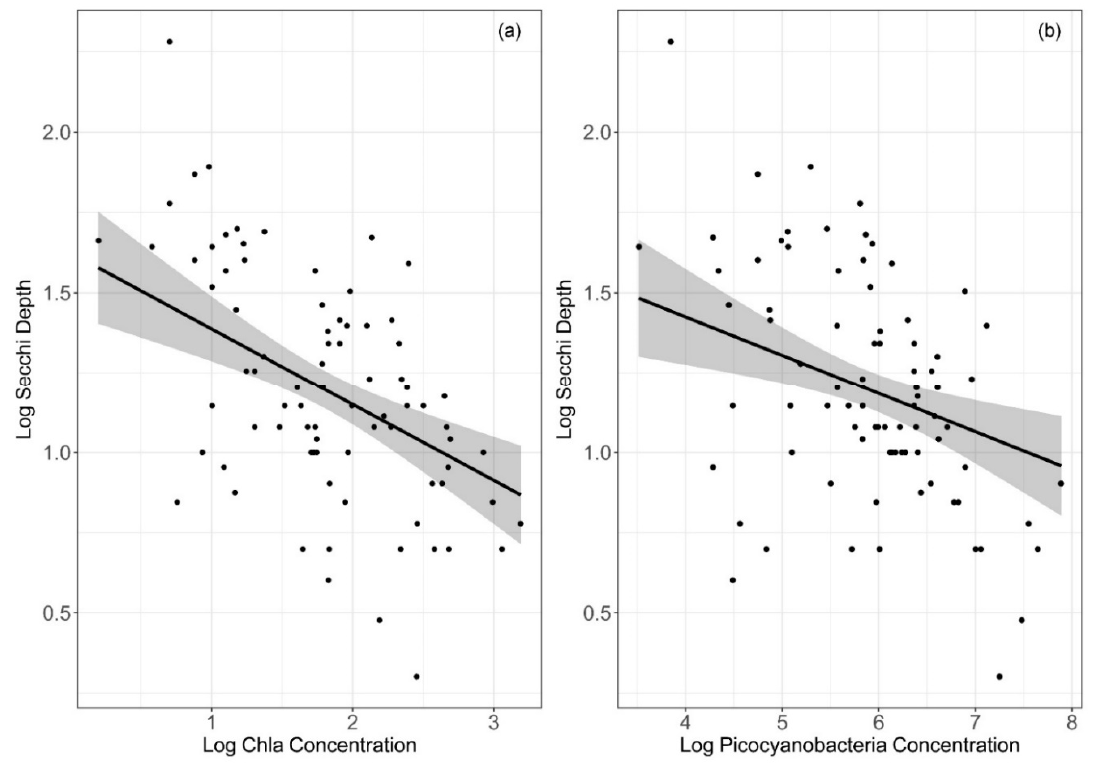
Figure 1. GAM results for spring–summer ZSD in shallow Pampean lakes, showing the fitted trend, confidence intervals, and observed values. Plots are partial plots of the smooth term in the model, and the y axis is the intercept plus the partial effect of the individual smooth. Data are log10 transformed, Chla was originally expressed in µ g L − 1 ( a ); picocyanobacterial abundance in cells mL − 1 ; and ZSD in cm ( b ). Table 3. HGAM results from the “historical” dataset exploring the functional relationship between ZSD and Chla. The two periods contrasted are: 1984–1999 (20th century) and 2000–2001 (21st century). Two slightly different model structures are presented (S and I, see Materials and Methods section). p -values associated with each term are listed in their order of appearance in the mathematical function; p -values < 0.05 are statistically significant; AIC, Akaike Information Criterion; delta AIC is the difference between a given model AIC with respect to the lowest AIC model; edf, estimated degrees of freedom for *, 20th century, 21st century.